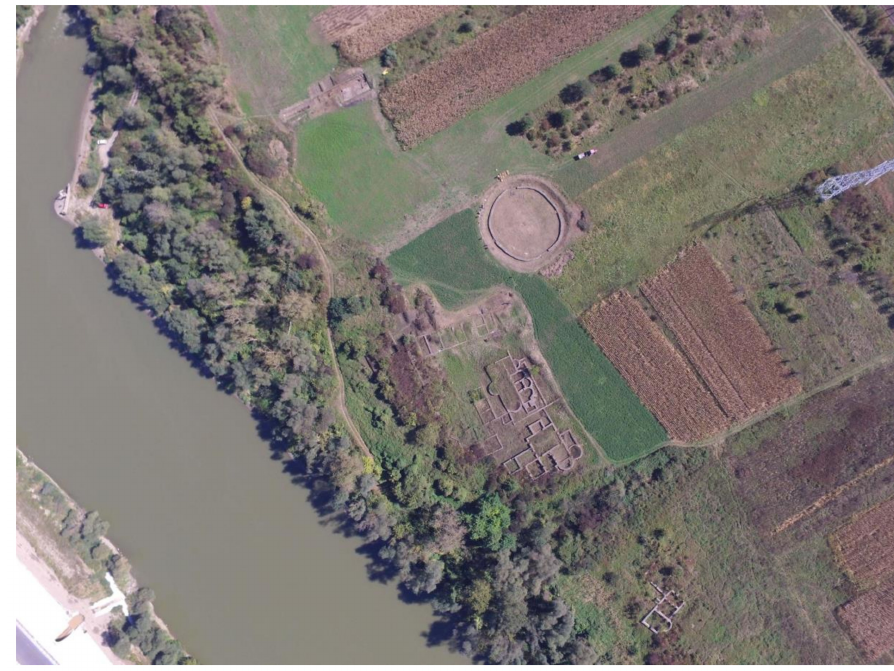
Figure 2. Aerial view of the Micia archaeological site – thermae and amphitheatre ( ©